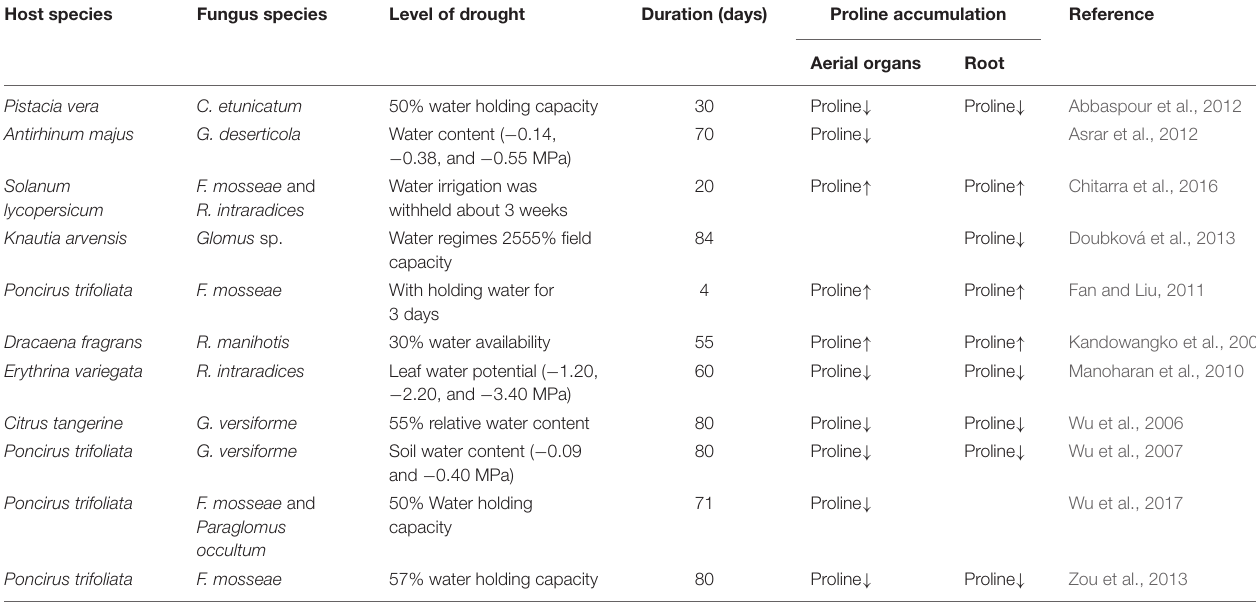
TABLE 2 | Level of proline accumulation influenced by drought stress in Arbuscular Mycorrhizal symbiotic